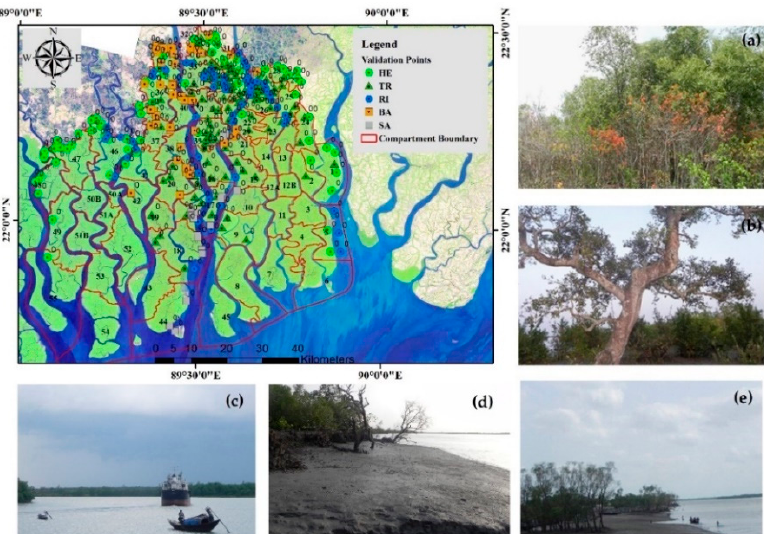
Figure 3. Location of field survey and validation points (color code represents five Land Use (LU) types of SRF overlay on Landsat images from 2019 (band combination used: R, G, B: 1, 2, 3 for background display only) along with corresponding field photographs: ( a ) light forest (HE); ( b ) dense forest (TR); ( c ) water bodies (RI); ( d ) bare land (BA); ( e ) sandy area (SA).